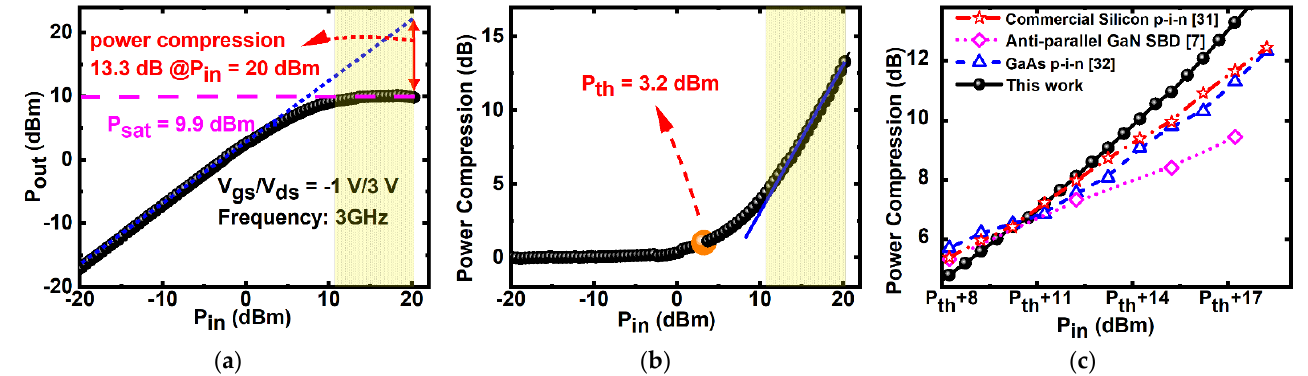
Figure 3. ( a ) Output power (P out ) versus input power (P in ) for the single GaN HEMT RP at 3 GHz; ( b ) power compression as a function of P in ; ( c ) comparison of the power compression between this single GaN HEMT and diode–based RPs in the literatures.